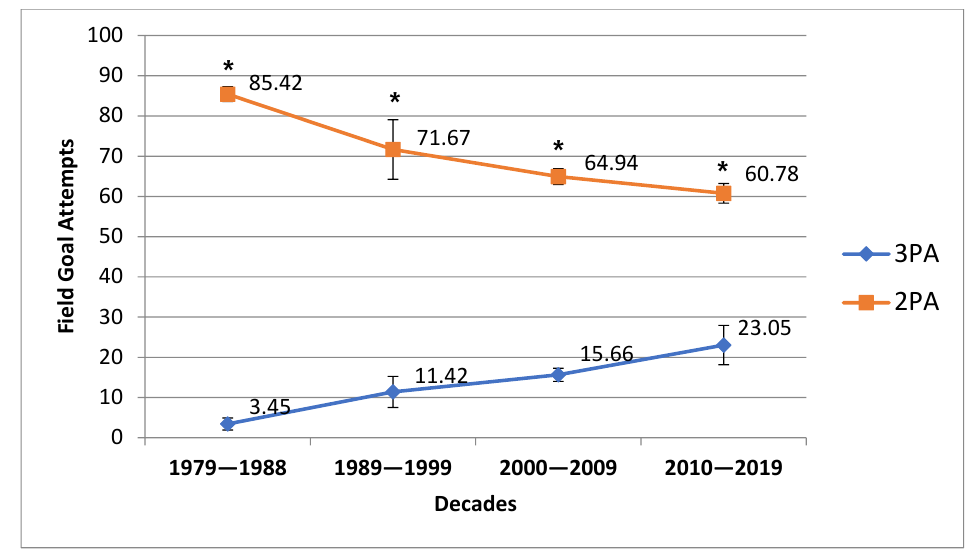
Figure 1. Three-point and two-point field goal attempt trends over the last 40 NBA seasons. * Statistically significant compared with the previous decade with p < 0.05. Table 2. Results of ANOVAs or Friedman tests and post hoc comparisons between decades for 3PA, 3PM and 2PA, 2PM.